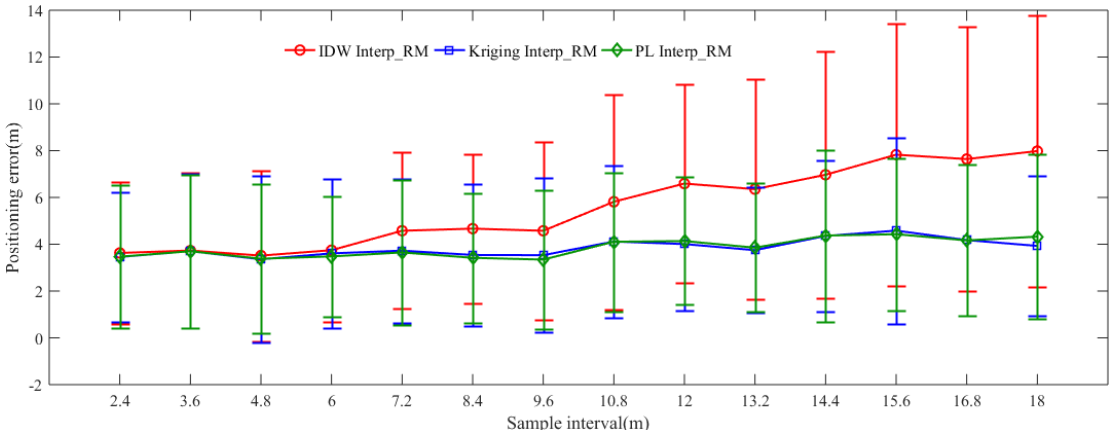
Figure 8. Localization accuracy of three interpolated radio maps generated by sparse RPs with different intervals.